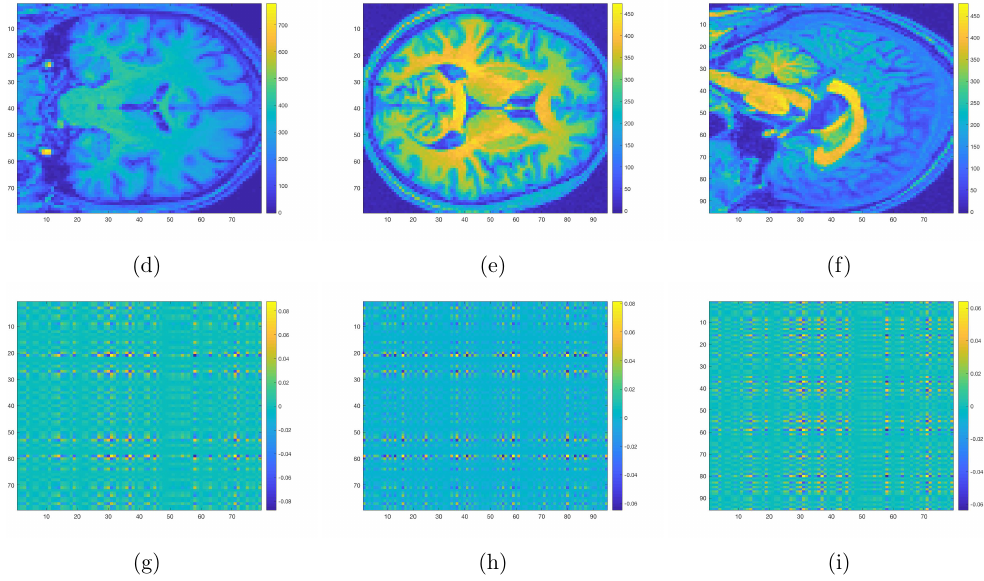
Figure 3. Three-dimensional sMRI images for DPD ( a – c ), NDPD ( d – f ), and the heatmaps for co- efficient matrices corresponding to three different surfaces respectively ( g – i ). Voxels with yellow and dark blue colors correspond to regions with aberrant structural changes for DPD compared with